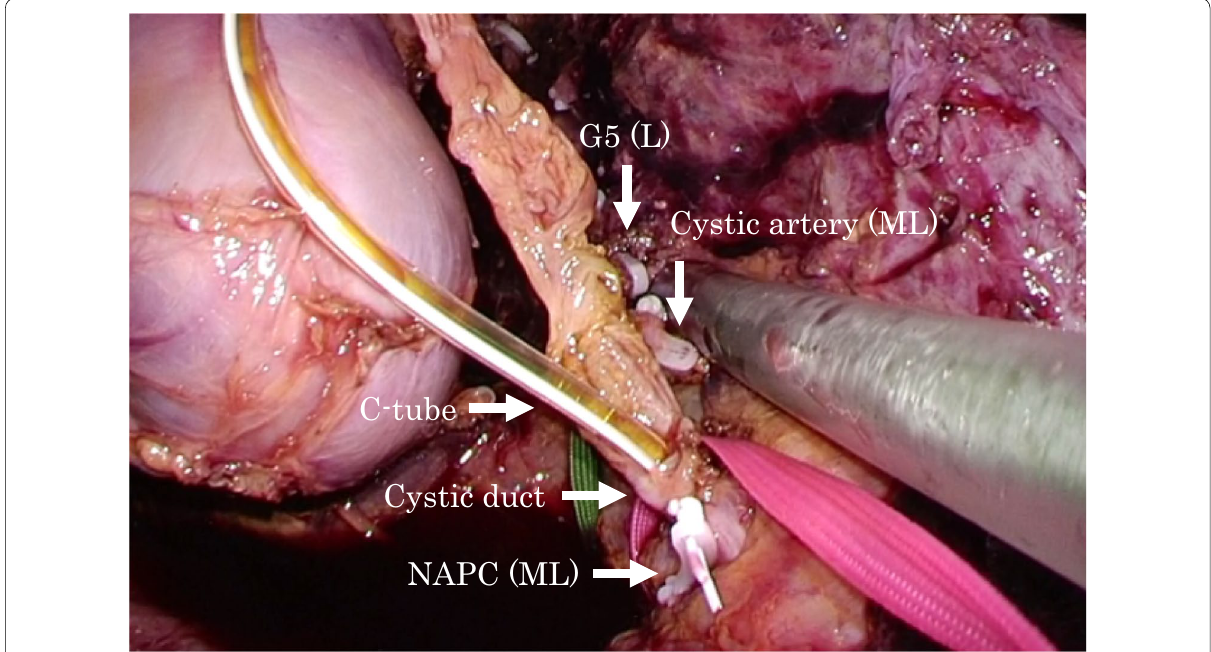
Fig. 6 Intraoperative findings for case 4. A laparoscopic S5 segmentectomy, S7 partial liver resection, and cholecystectomy were performed for liver metastasis from lung cancer and cholelithiasis. Medium-large NAPCs were placed at the cut surface of the liver and the cystic artery. Large NAPCs were placed at the Glissonean pedicle of segment 5. A trans-cystic drainage tube was inserted, and it was ligated and fixed with medium-large